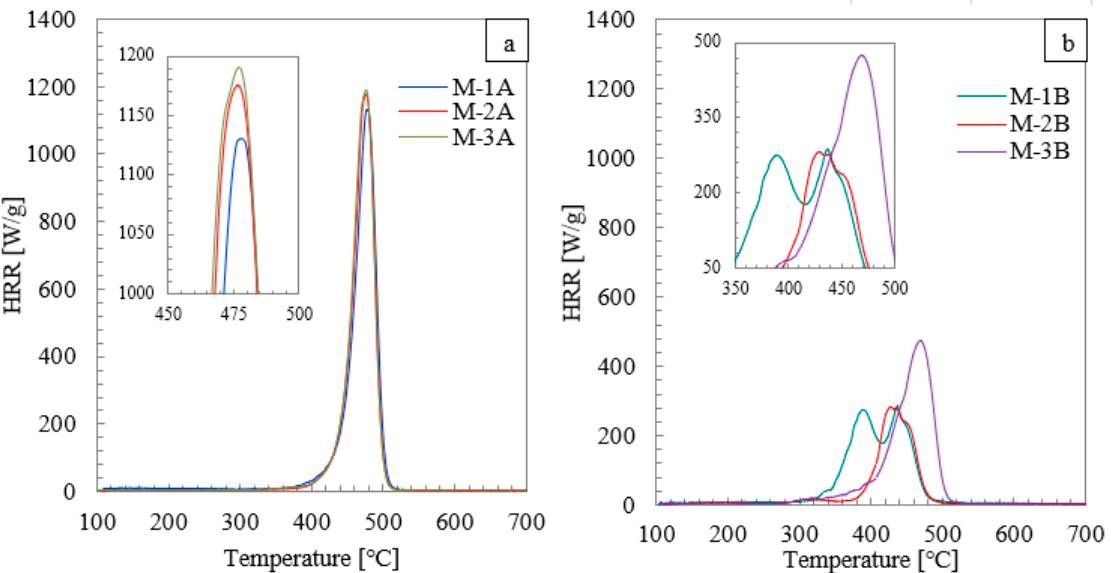
Figure 4. The heat release rate dependence as a function of temperature for samples ( a ) M-1A, M-2A, and M-3A and ( b ) M-1B, M-2B, and M-3B.